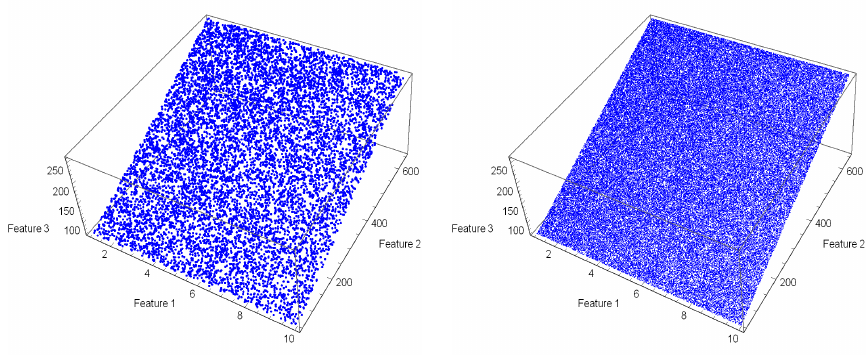
Figure 3. The lending portfolio having different sizes, ( left ) for 10,000 and ( right ) for 100,000.